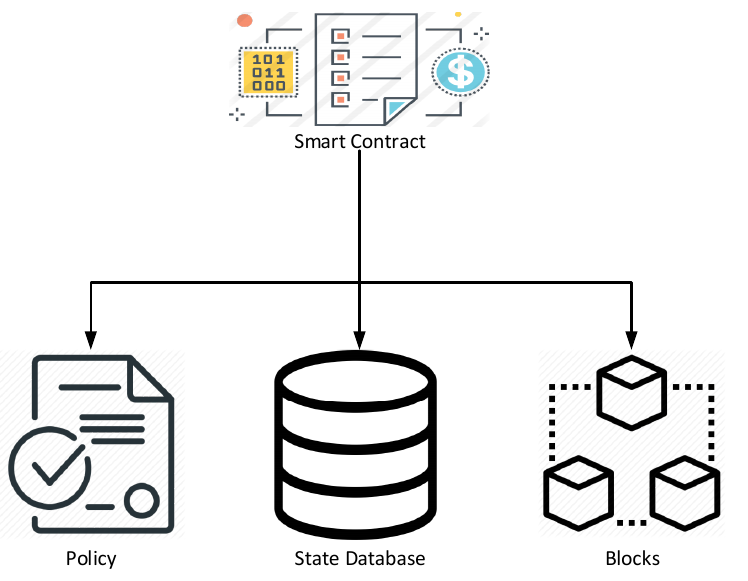
Figure 5. Representation of the node in the proposed blockchain platform.